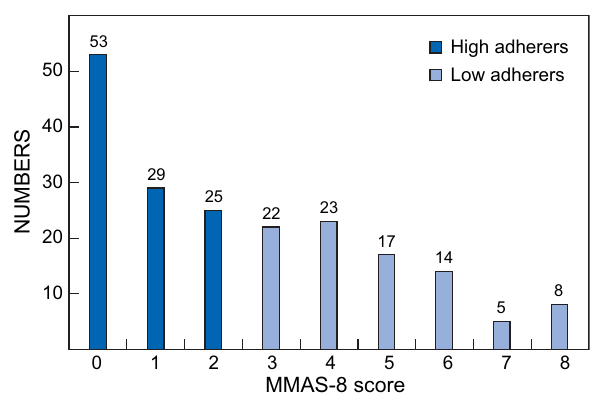
Figure 1: Distribution of participants according to their MMAS-8 medication adherence score ( n =